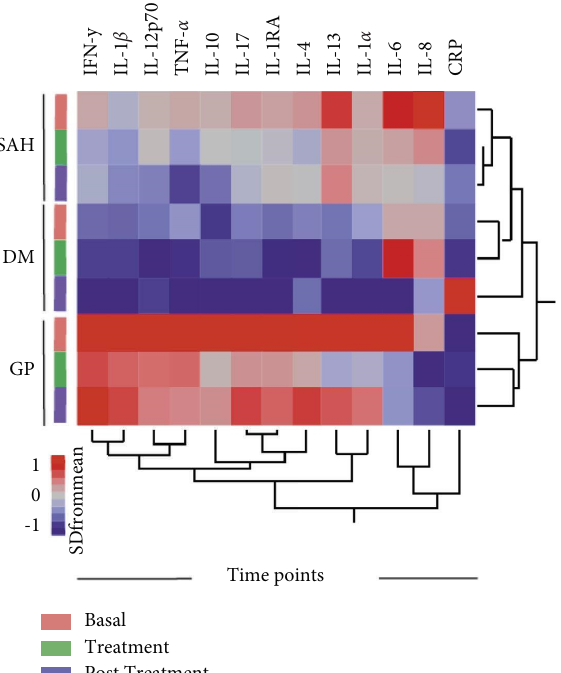
Figure 4: Heatmap demonstrating the infammatory profle of patients according to the main aetiologies of kidney disease. Te heatmap shows data for the mean plasma concentration of each indicated marker according to the main aetiologies of kidney disease, and the data were log-transformed and Z score normalized. A hierarchical cluster analysis (Ward’s method with 100X bootstrap) was used to group the biomarkers with similar distributions between the time points. Dendrograms represent Euclidean distance. DM: diabetes mellitus; GP: glomerulopathies; SAH: systemic arterial